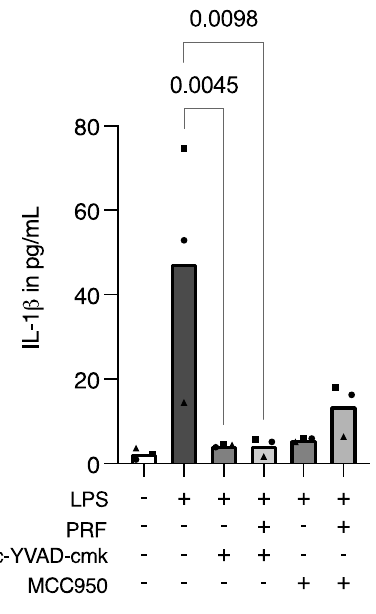
Figure 4. PRF exerts similar activity to pyroptosis-specific inhibitors regarding the release of IL-1 β in LPS-induced RAW 264.7 macrophages. A reduction in IL-1 β in LPS-induced RAW 264.7 macrophages was reported after cell stimulation with Ac-YVAD-cmk and MCC950, in the presence or not of PRF in RAW 264.7 macrophages. Each data point represents an independent experiment. n = 3. To compare groups, the Friedman test followed by Dunn’s multi-comparison test was